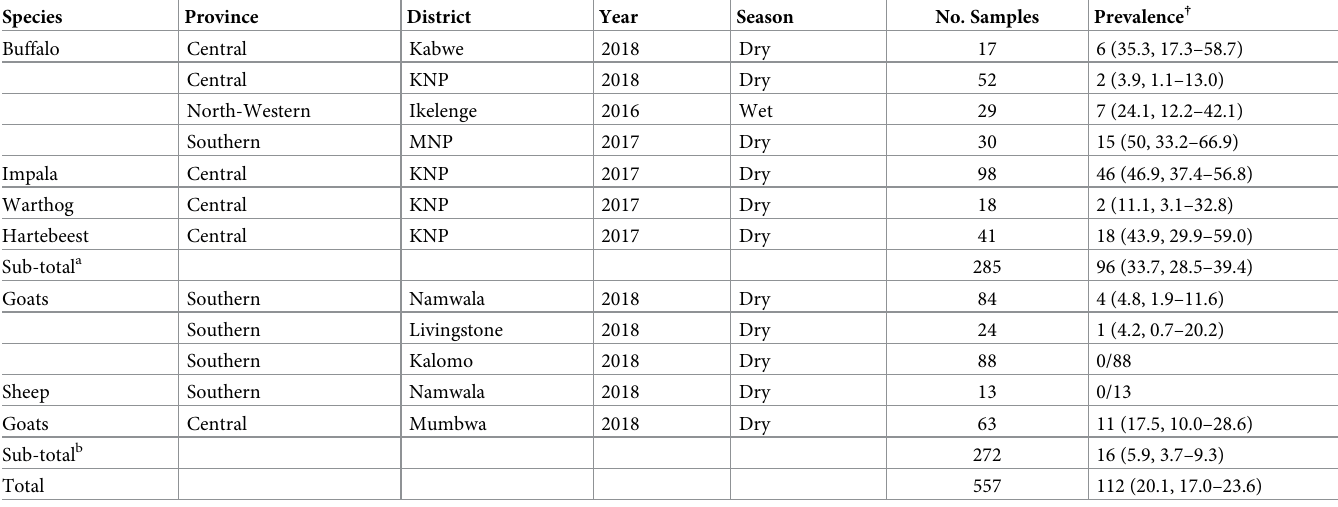
Table 4. RVF seroprevalence in wild and domestic ruminants from Zambia.